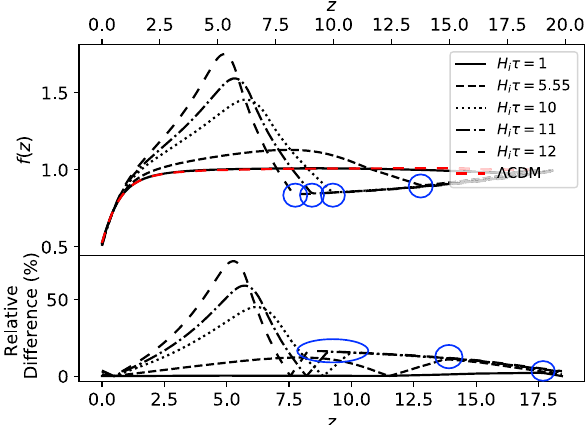
Fig. 7 The evolution of the growth rate f ( z ) . Time-delayed cosmol- ogy with intermediate (i.e. H i τ ∼ 10) delay parameter values predict markedly different growth rate evolutions. In particular, the predictions for time-delayed cosmology decreases initially before increasing and eventually peaking. There are also kinks (encircled in blue) in the pre- dictions. Note that the non-circled sharp turns on the bottom plot are inflection points produced when taking the absolute value of the relative difference and do not correspond to predicted physical